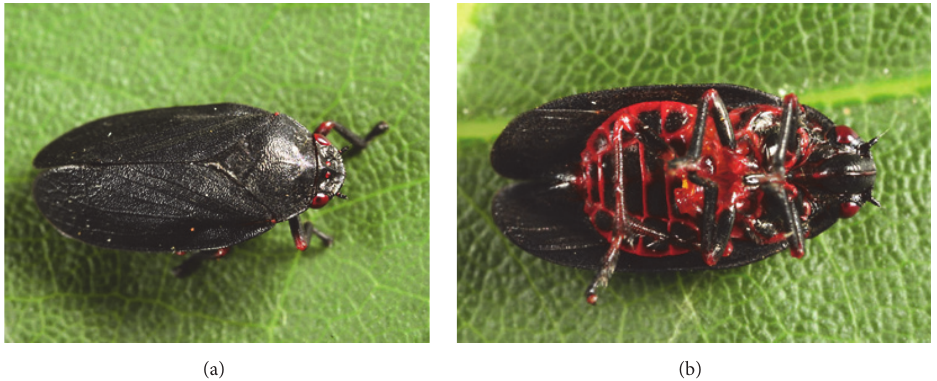
Figure 2: Prosapia ignipectus , black form: (a) dorsal view and (b) ventral view. Photographs by Tom Murray.